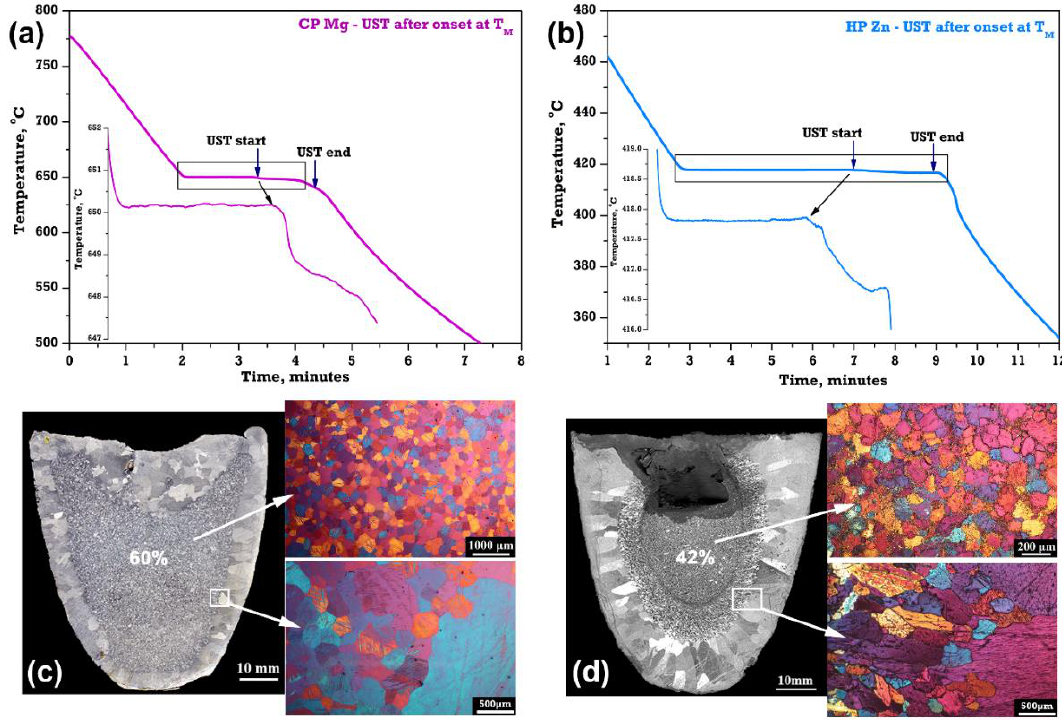
Figure 15. ( a , b ) Cooling curves, ( c , d ) grain structures in the macrostructure and microstructure of pure ( a , c ) Mg and ( b , d )